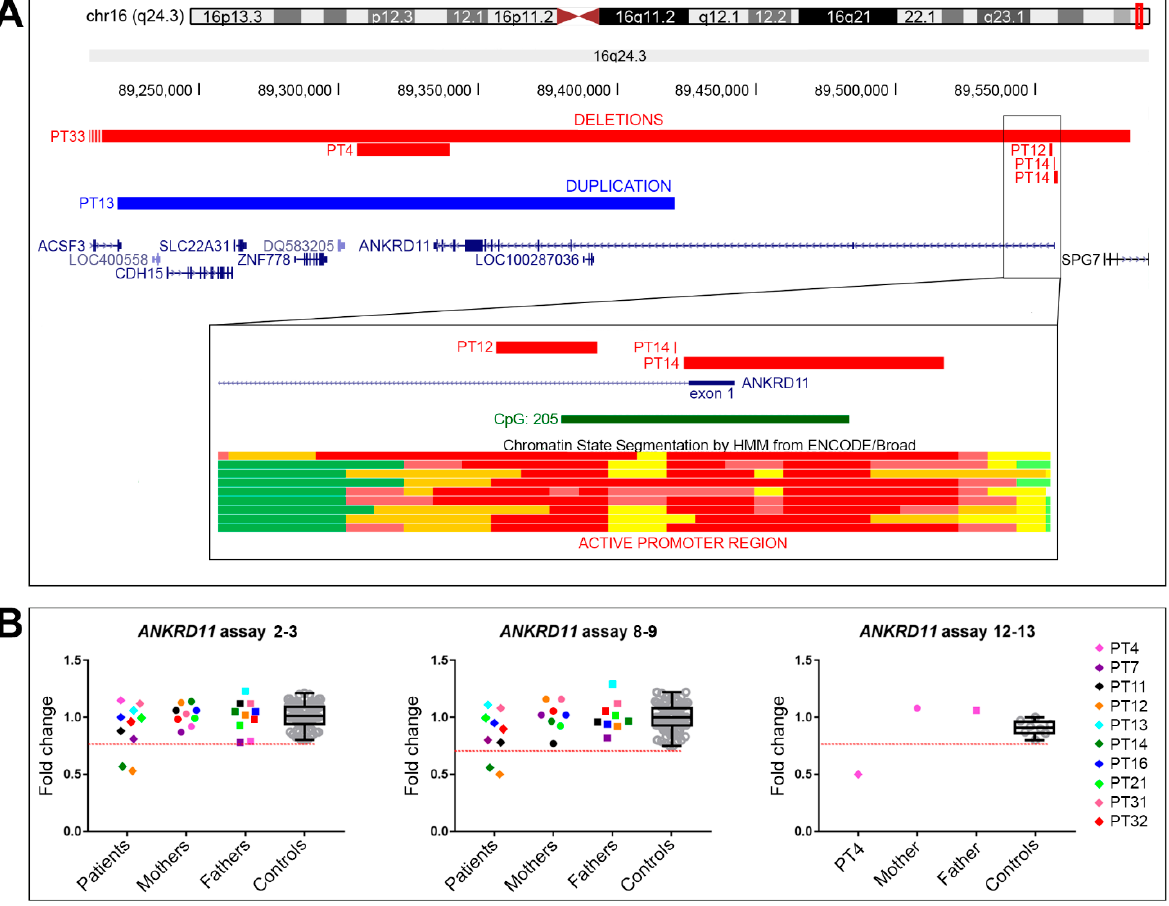
Figure 3. ANKRD11 structural variants detected by CMA and gene expression analysis (RT-qPCR). ( A ) Physical map of the 16q24.3 region showing deletions of patients PT4 and PT33 as horizontal red bars, while the duplication of PT13 as a horizontal blue bar. Deletions of PT12 and PT14 are shown enlarged in the box. The genes mapping in this region are in blue characters, the CpG island